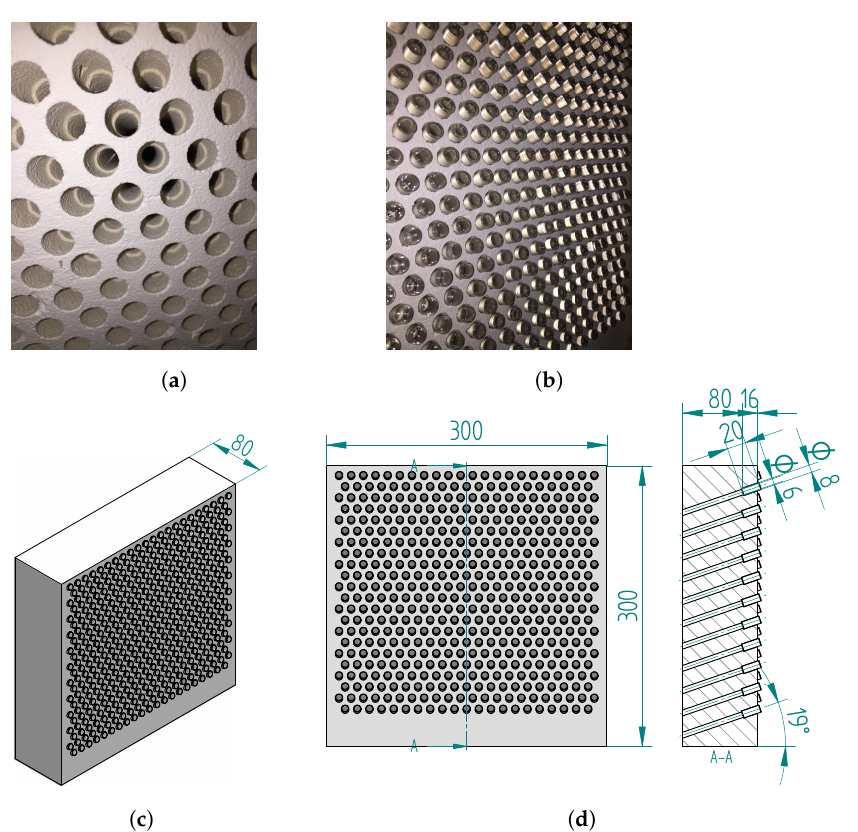
Figure 1. Solar active thermal insulation system (SATIS). ( a ) Front view of the manufactured panel prototype of SATIS (state 2). ( b ) Panel of SATIS closed on the outside surface with borosilicate glass cylinders (state 3). ( c ) Isometric view of SATIS. The nominal length given is in millimeters. ( d ) Front (left) and sectional (right) view of SATIS. The stepped holes are closed on the outside surface with borosilicate glass cylinders. The nominal lengths given are in